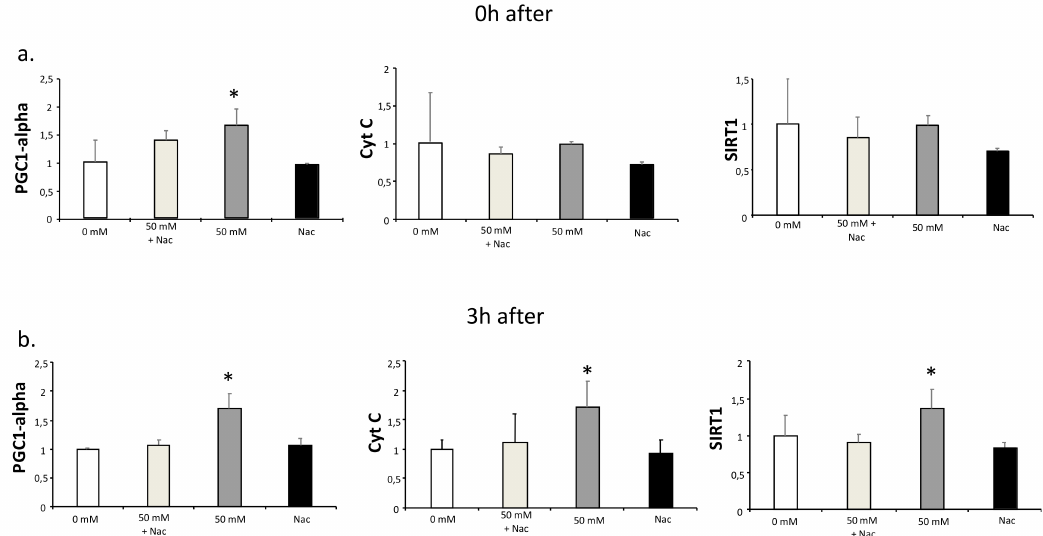
Figure 2. qPCR analysis of PGC1-alpha, Cyt C, and SIRT1 in C2C12 myotubes cultured with lactate and N-acetyl-L-cysteine (Nac). C2C12 myotubes were cultured for 2 h with L-lactate (0 and 50 mM)